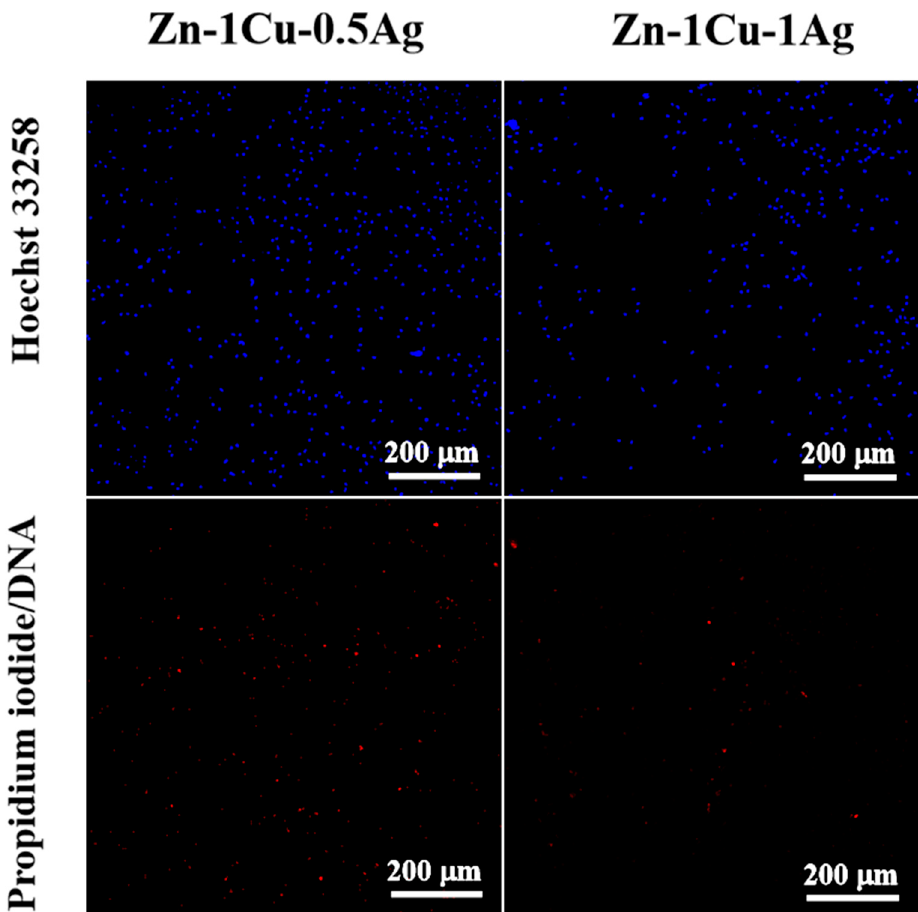
Figure 7. Fluorescence images of MC3T3-E1 cells adhering to the surface of the Zn-1Cu-xAg (x = 0.5, 1) alloy.